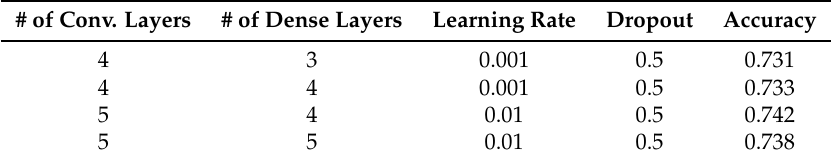
Table 1. Training of a simple Convolutional Neural Network (CNN) from scratch. # of Conv. Layers